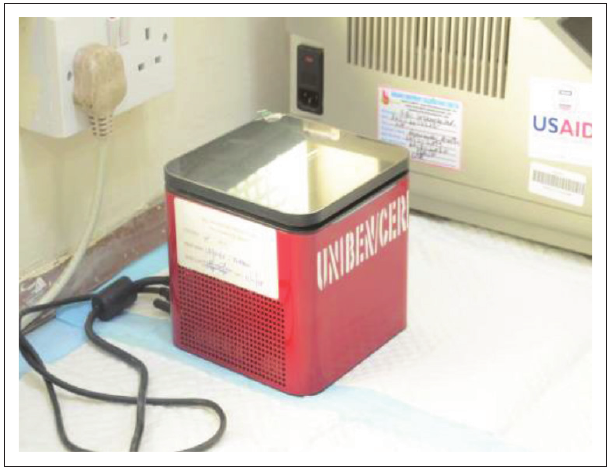
FIGURE 2: Magnetic induction cycler real-time Dx48 PCR instrument obtained from Centre for Excellence in Reproductive Health Innovation, Edo state, Nigeria, 2020.